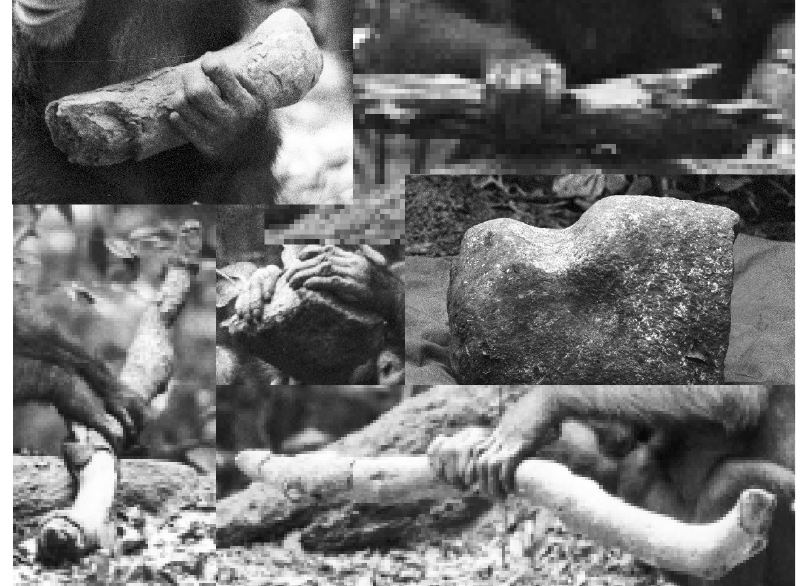
Natural Hammers Used by Chimpanzees in the Taï Forest to Crack